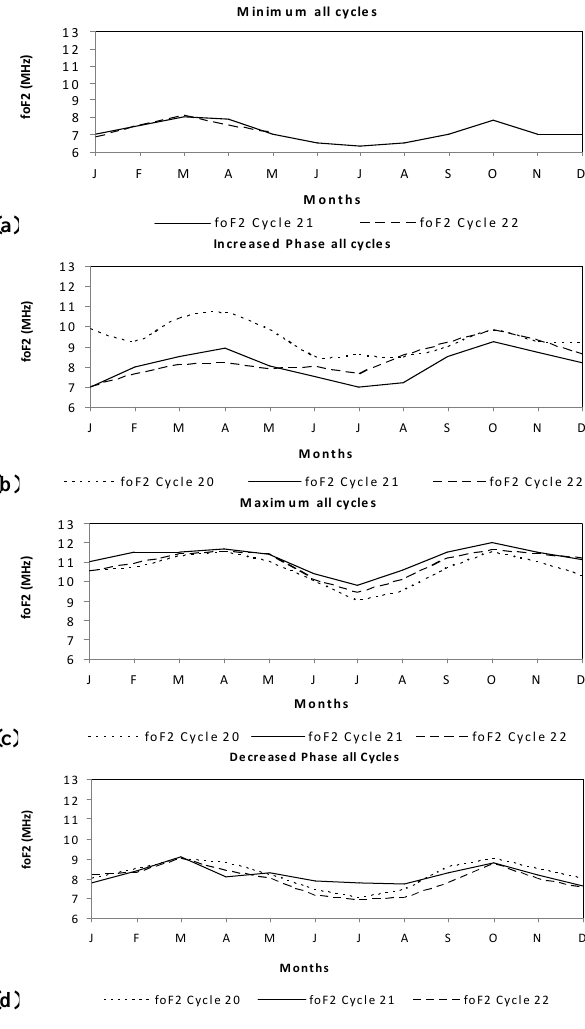
Fig. 3. From top to bottom: seasonal variation fo F2 during mini- mum phase (panel a ), increased phase (panel b ), maximum phase (panel c ) and decreased phase (panel d ) for three solar cycles: cy- cle 20 (dotted line); cycle 21 (continues line); cycle 22 (broken